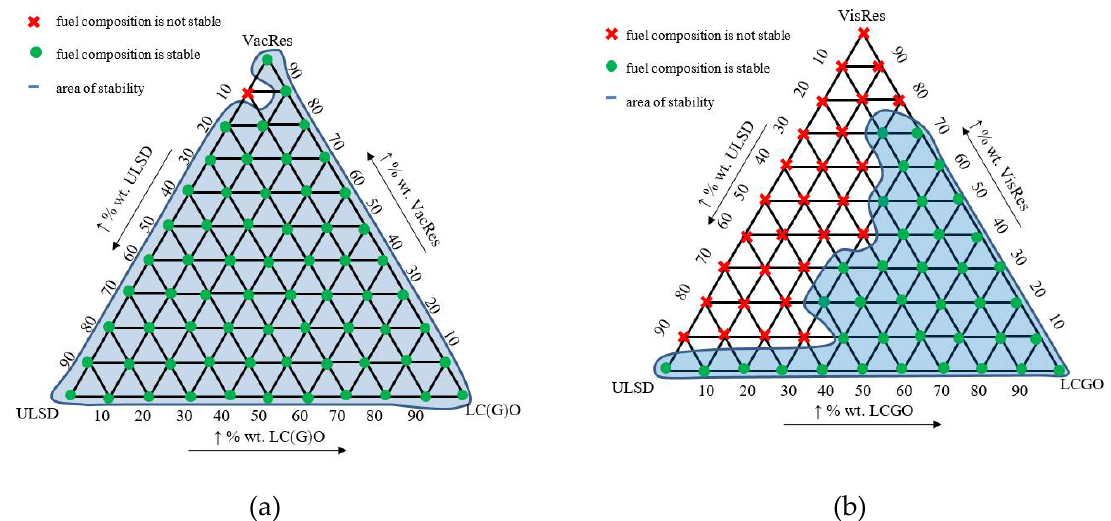
Figure 6. The ternary phase diagrams of stability of the residual marine fuel oil: ( a ) VacRes–ULSD–LCGO and ( b ) VisRes–ULSD–LCGO. Table 4. The quality indicators of commercial residual marine fuel of RMG 380.